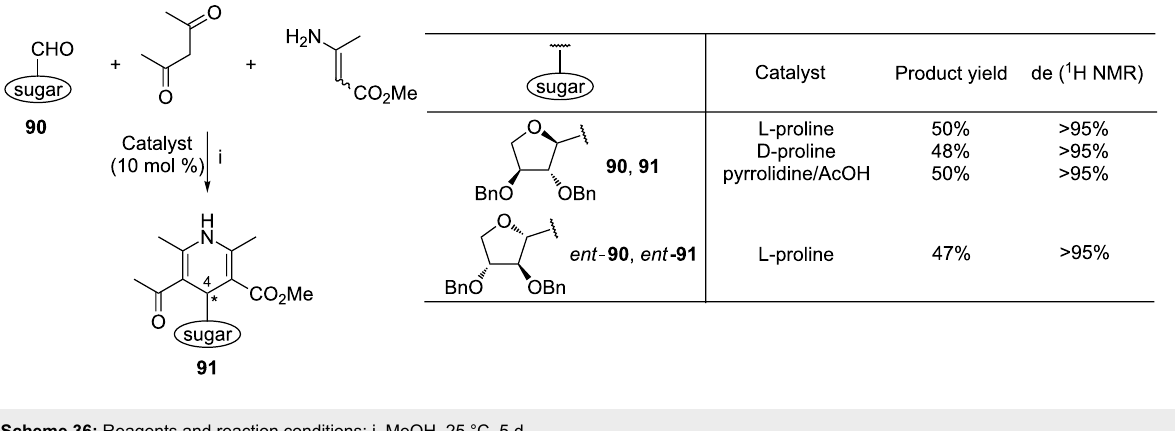
the same conditions. The absolute configuration of the C-4 carbon atom of compound 91 or ent- 91 was not